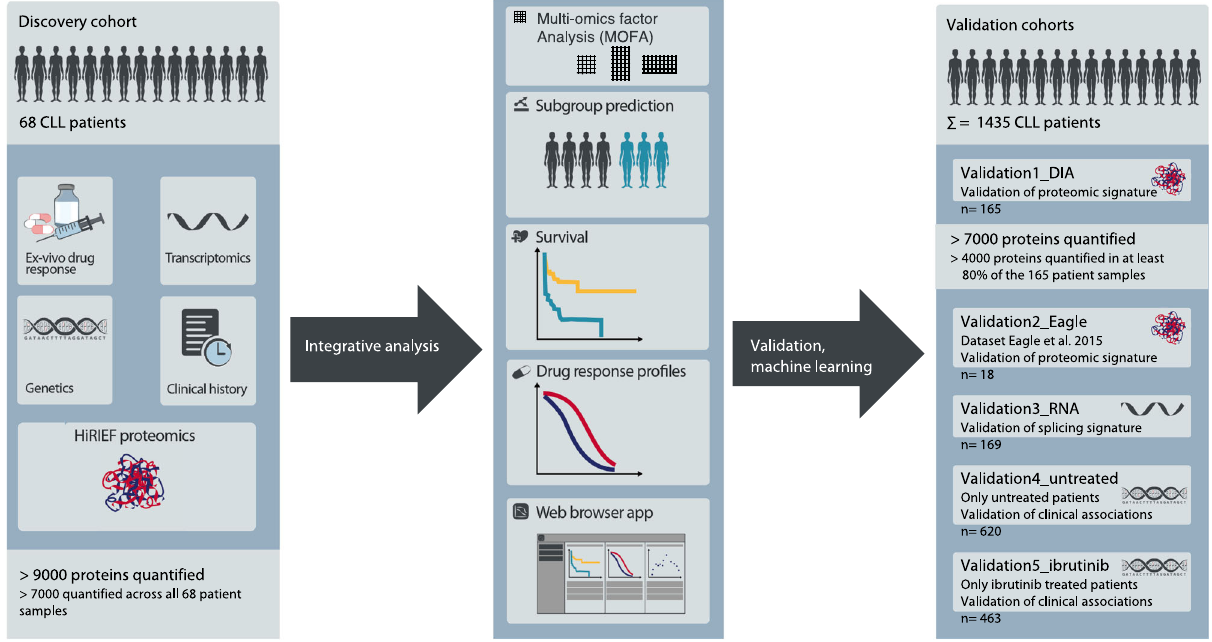
Fig. 1 | Overview of the study design. In-depth proteomics, transcriptomics, genetic and drug perturbation pro fi ling were performed for a discovery cohort of 68clinicallywell-characterizedCLLpatients.Anintegrativeanalysiswasperformed to describe associations between the different molecular layers and to uncover patient subgroups. These were validated in multiple independent cohorts using different validation strategies. To validate proteomic signatures, we performed data-independent acquisition (DIA) proteomics on 165 CLL patient samples